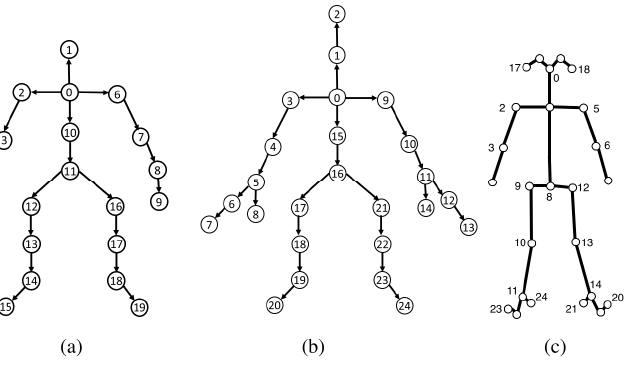
Figure 10. Human skeleton model by different techniques. ( a ): 20 joints (Kinect for Xbox 360), ( b ): 25 joints (Kinect V2) and ( c ): 25 joints OpenPose Body-25 methods [89].